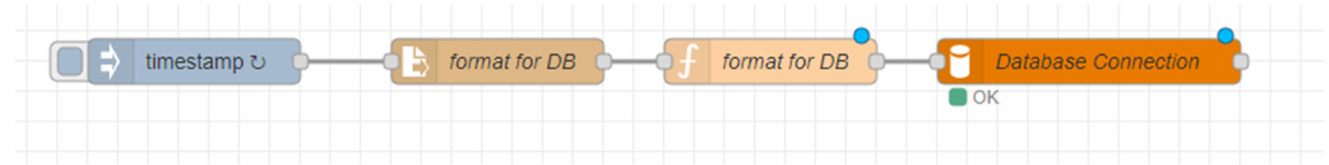
Figure 14. Nodered flow—3DExperience to MySQL.